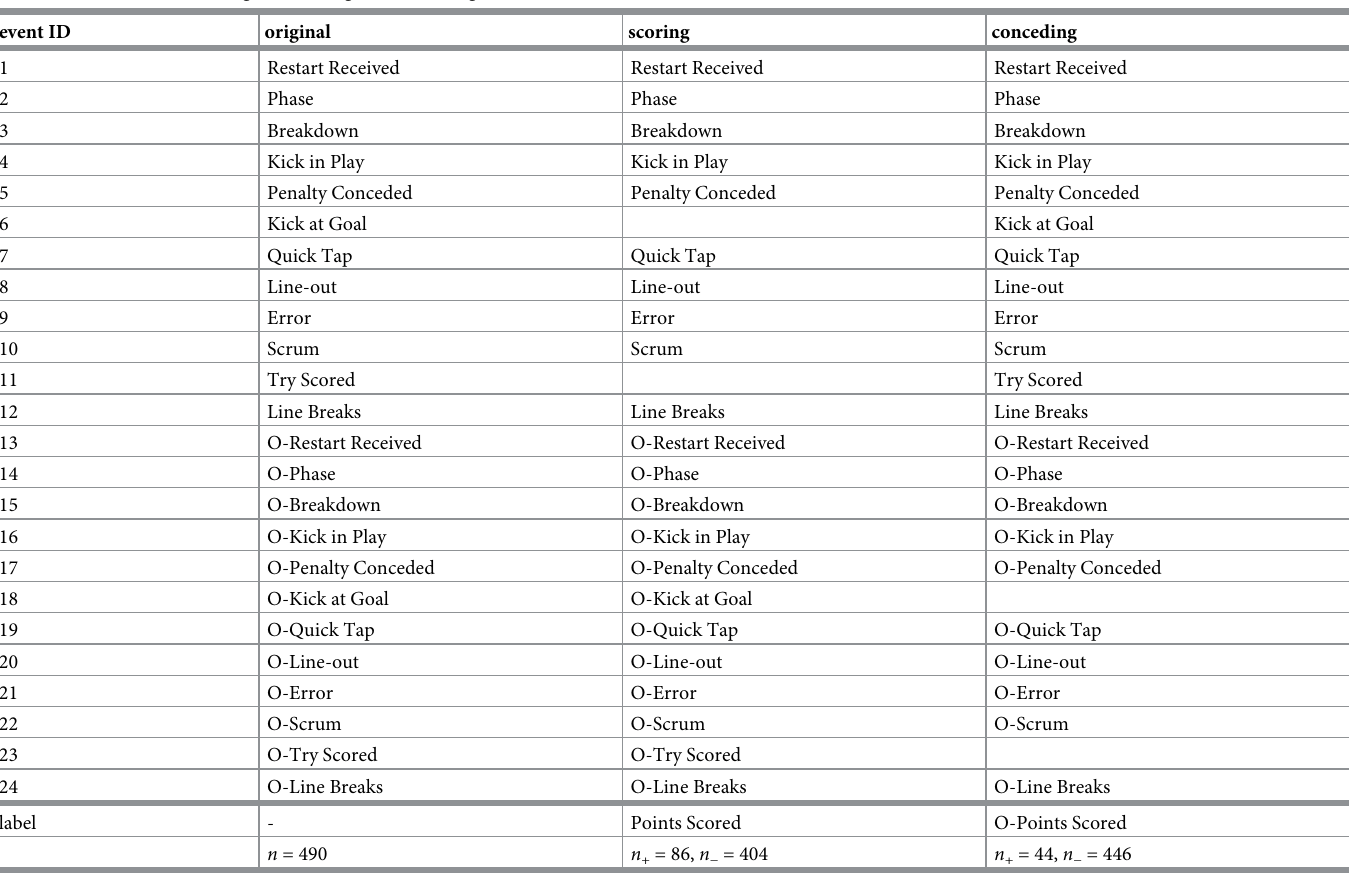
Table 3. Event lists for the original, scoring and conceding